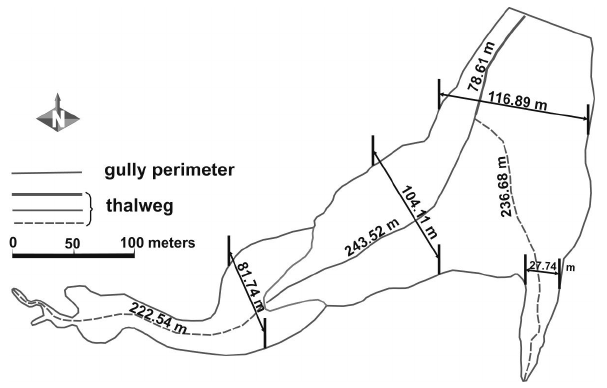
Fig. 7. Longitudinal profiles of surface and principal gullies on the Cucuteni-Baiceni side gullies in 2008.